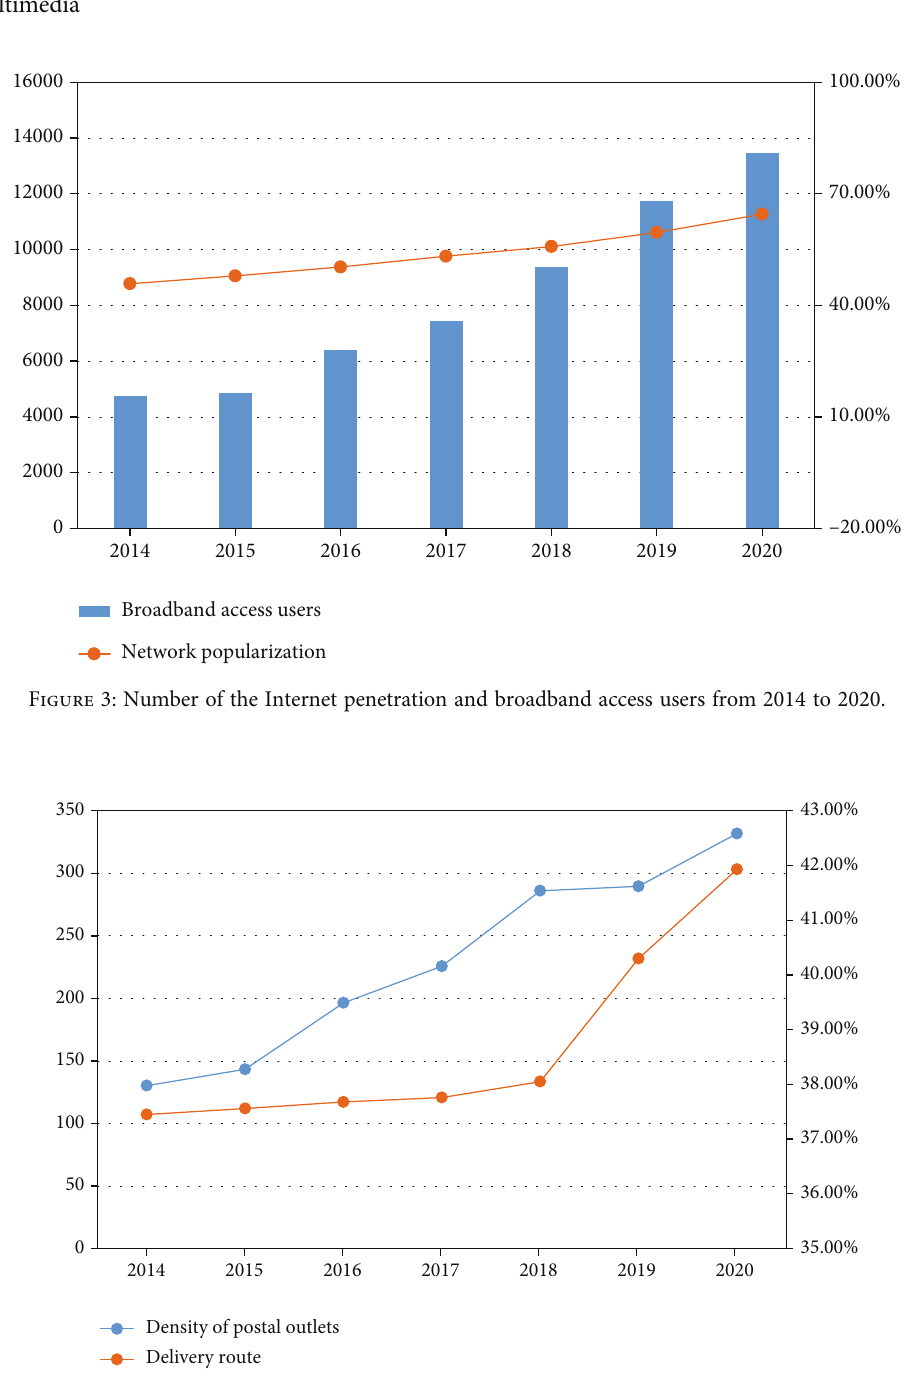
Figure 4: China ’ s delivery routes and postal business network density from 2014 to